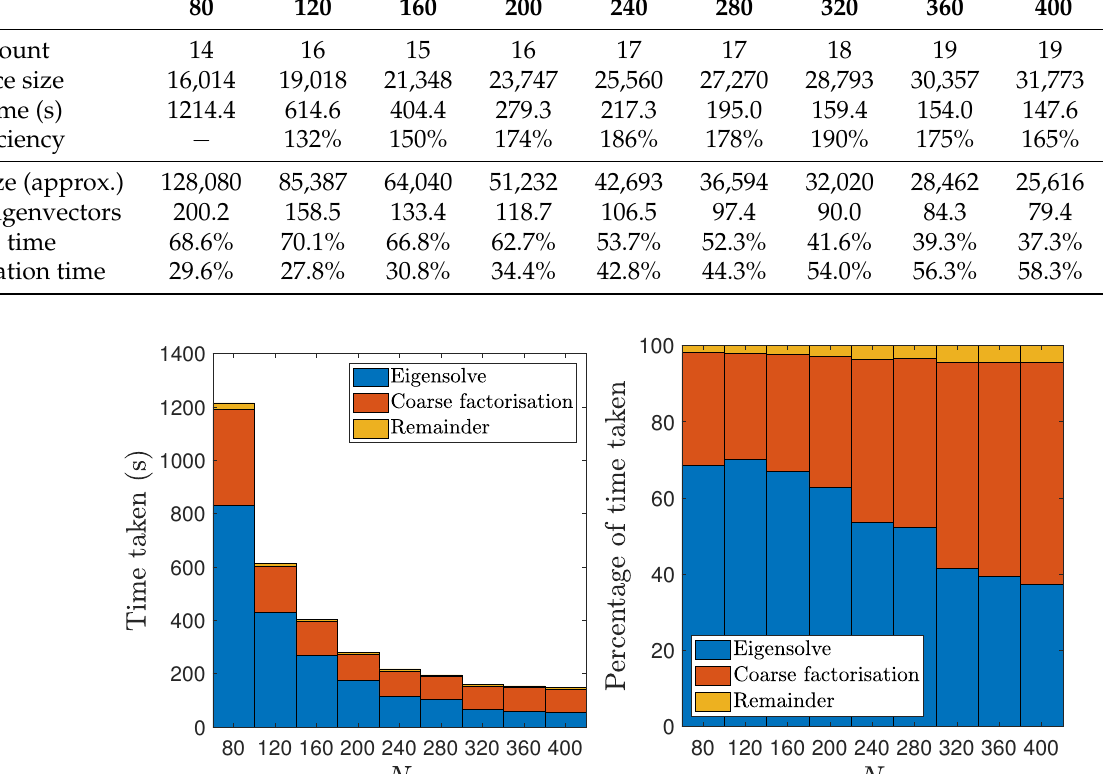
Figure 6. Timings for the homogeneous problem when using ORAS with H-GenEO ( 1 number of subdomains for k = 186.0 and h − 1 = 3200, giving a total of 10,246,401 dofs. A non-uniform decomposition into N subdomains is used, given by